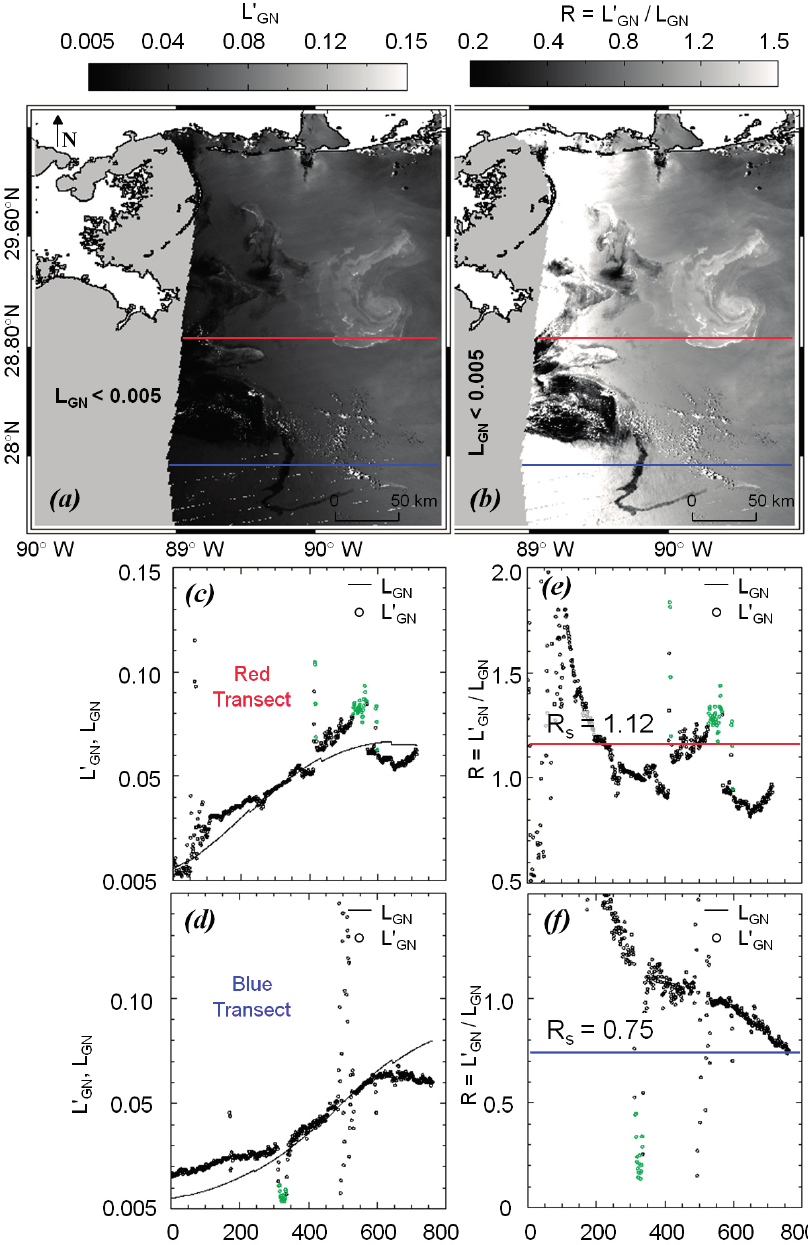
Figure 4. ( a ) MODIS-derived L' GN (bias-corrected), relative to Scene 7 of Table 1 (Gulf of Mexico, positive and negative oil spill-water contrast); ( b ) R = L' GN / L GN ; ( c,d ) comparison between L GN (solid line: Cox and Munk (1954) isotropic) and L' GN (dotted line) along the transects crossing the spills with negative (red line in (a)) and positive contrast (blue line in (a)). Green dots denote the oil spill pixels in the corresponding ROI; ( e,f ) R values along the transects (red and blue line in (b)) with green dots for oil spill pixels. Solid red lines represent the oil spill separation index value R s from Table